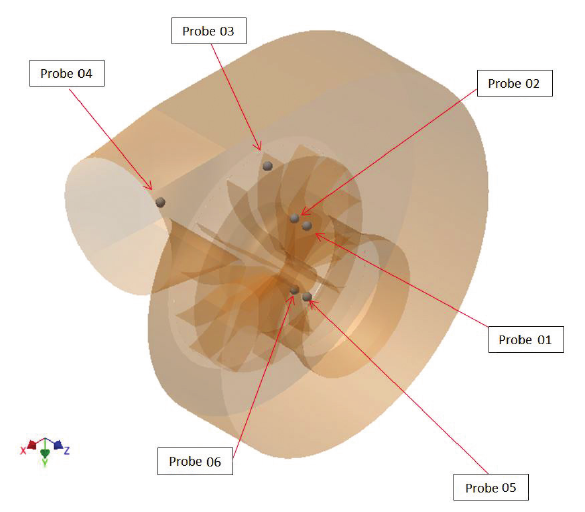
Figure 30 - Positions of the numerical probes in the computational